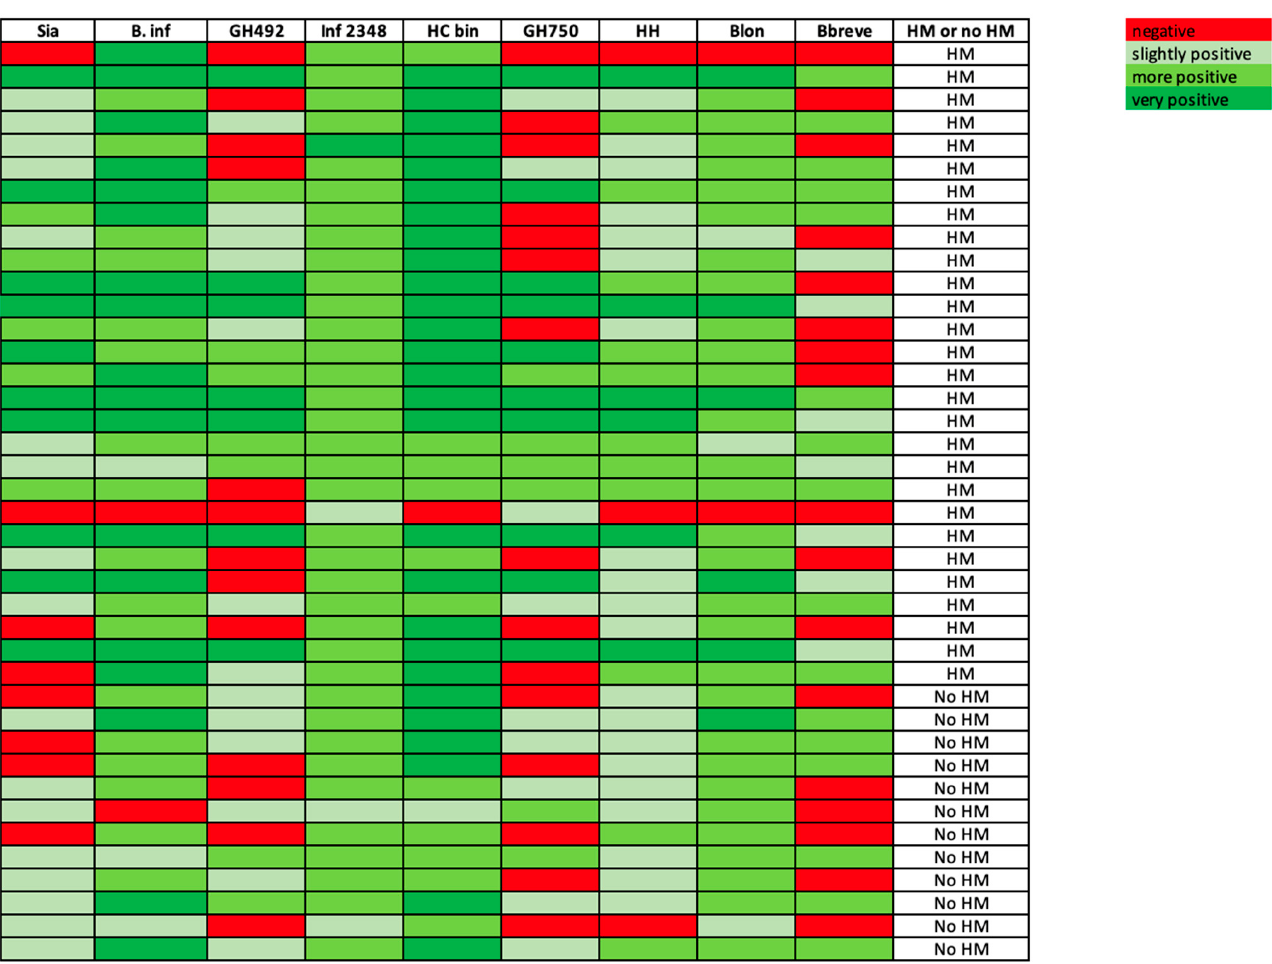
Figure 1. Heat map of the HMO-metabolizing genes detected in each of the infant stool samples. The colors show the range from negative (red) to very positive (dark green), with the top portion of the map being infants fed some amount of human milk, and the infants in the bottom portion not consuming any human milk at the time of sample collection.